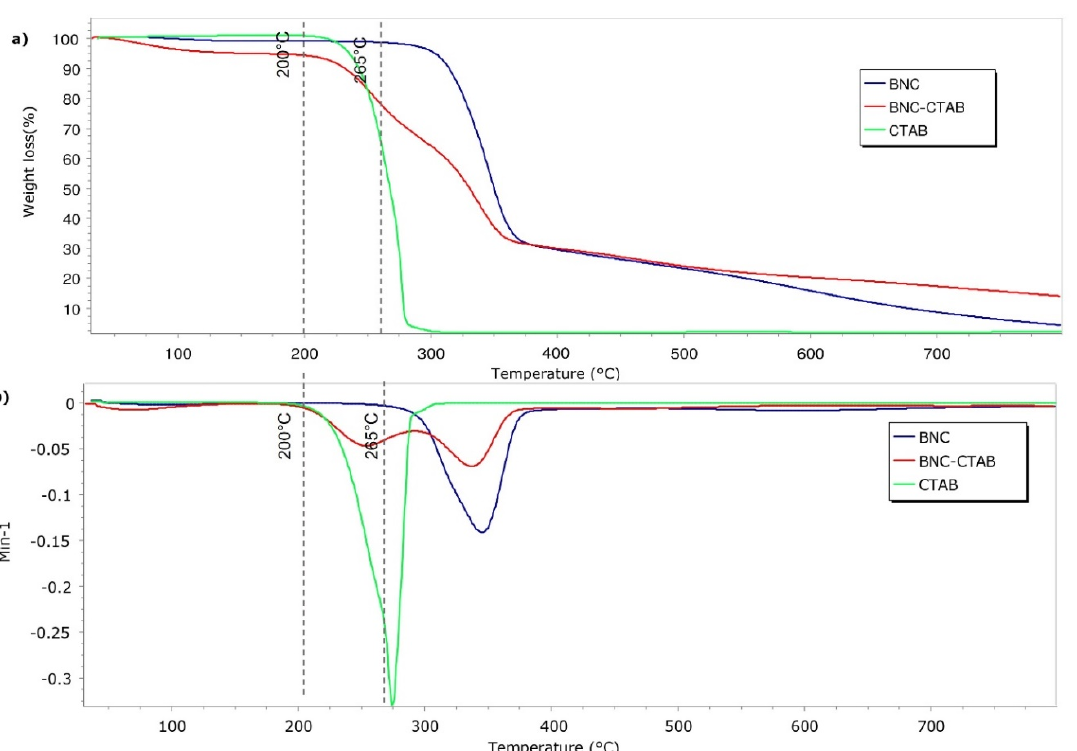
Figure 4. FTIR spectrum of BNC, BNC-CTAB, and free CTAB.